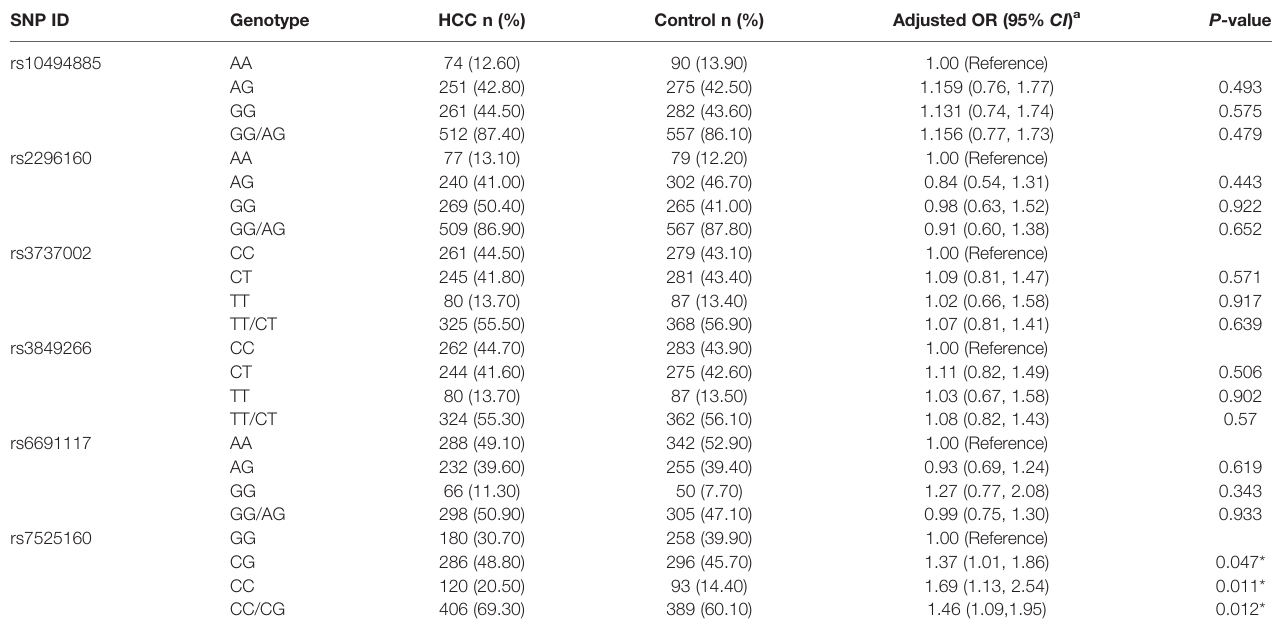
TABLE 2 | SNPs of CD35 gene in patients with HCC and